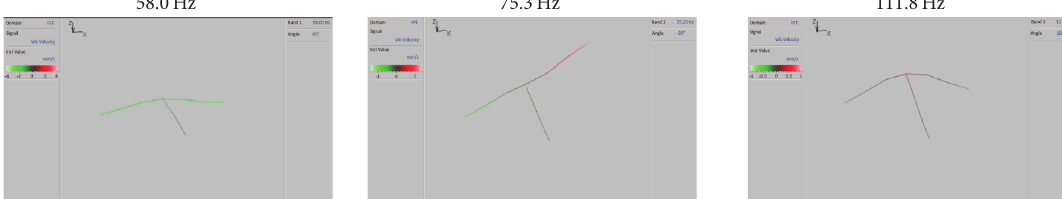
Figure 15: Operational deflection shapes of the T-beam system with thin secondary beam.